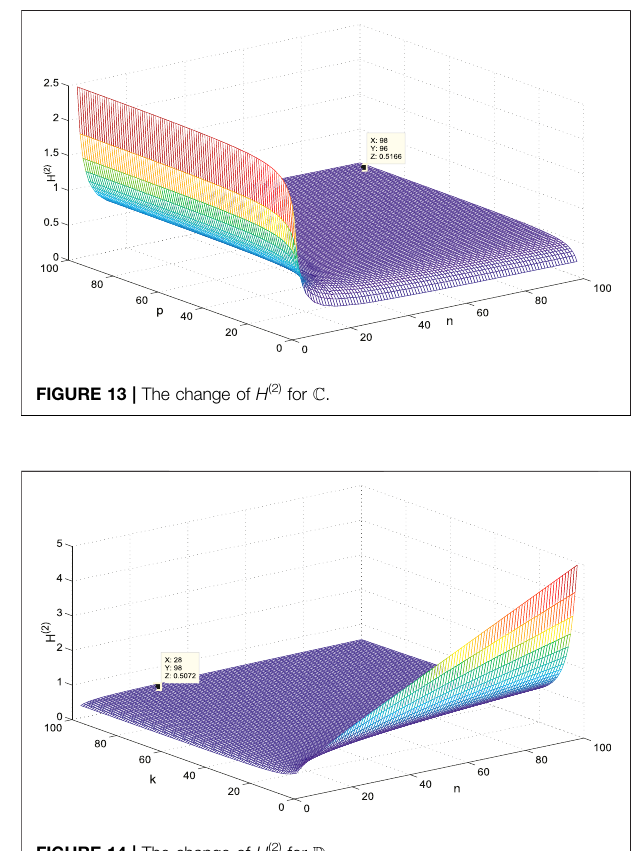
FIGURE 14 | The change of H (2) for D